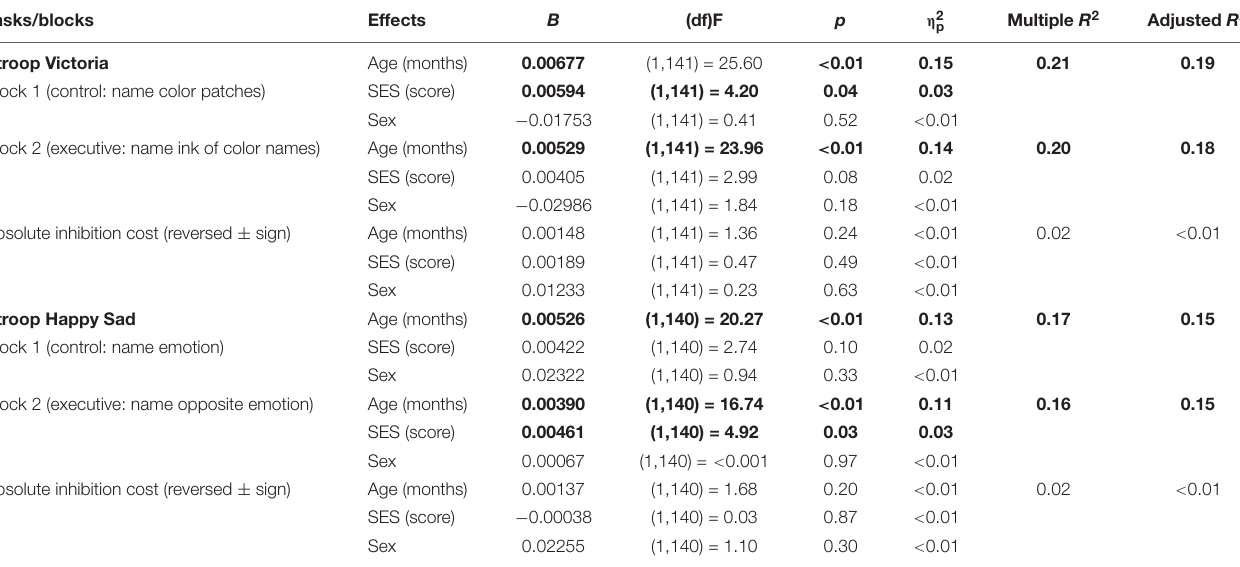
TABLE 3 | Results from the General Linear Models for executive inhibition tasks/blocks and absolute executive costs, including age, sex and socioeconomic status (SES) effects.